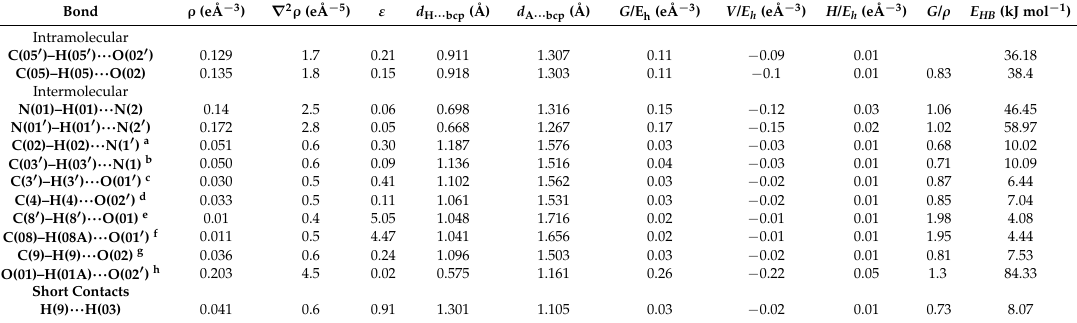
Table 2. Topological analysis of hydrogen bonding in ( 3 ). Standard uncertainties have been omitted from the table for clarity. They are closely scattered around 0.02 eÅ − 3 ( ρ bcp ) and 0.05 eÅ − 5 ( ∇ 2 ρ bcp ).